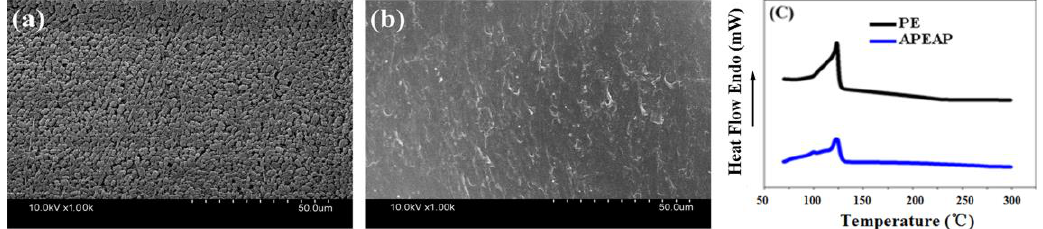
Figure 5. The SEM image of PE membrane before and after heat treatment and DSC curves of PP/PE/PP, PE, and APEAP membrane: ( a ) before, ( b ) after, ( c ) DSC curves of PE and APEAP membrane.